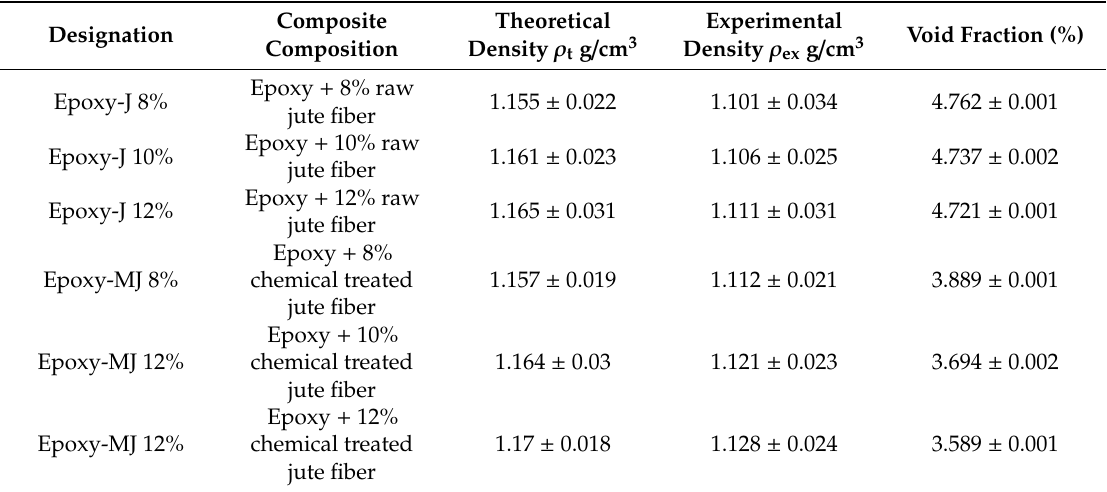
Table 3. Void fraction of di ff erent jute fiber composites.